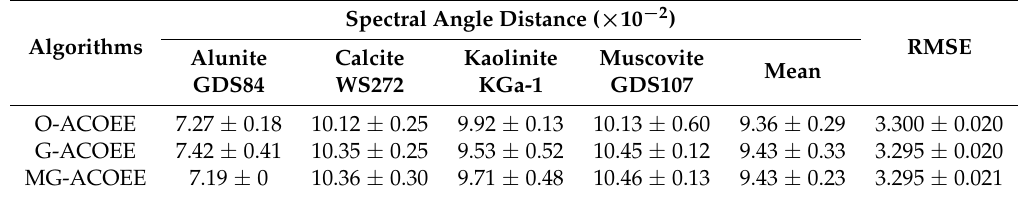
Table 3. Comparison of O-ACOEE, G-ACOEE, and MG-ACOEE (full constraint) on endmember extraction accuracy for Cuprite data.